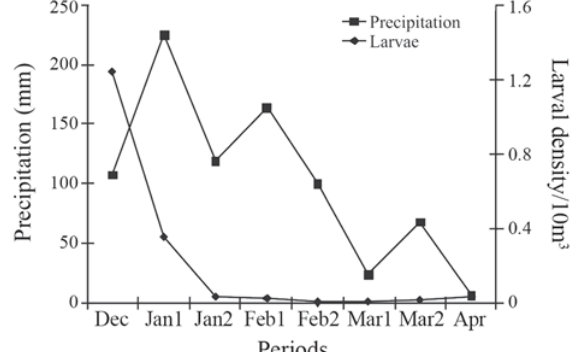
Fig. 7. Correlation of the mean larval density and precipitation in marginal lagoons along the Cuiabá River between December 2006 and April 2007.